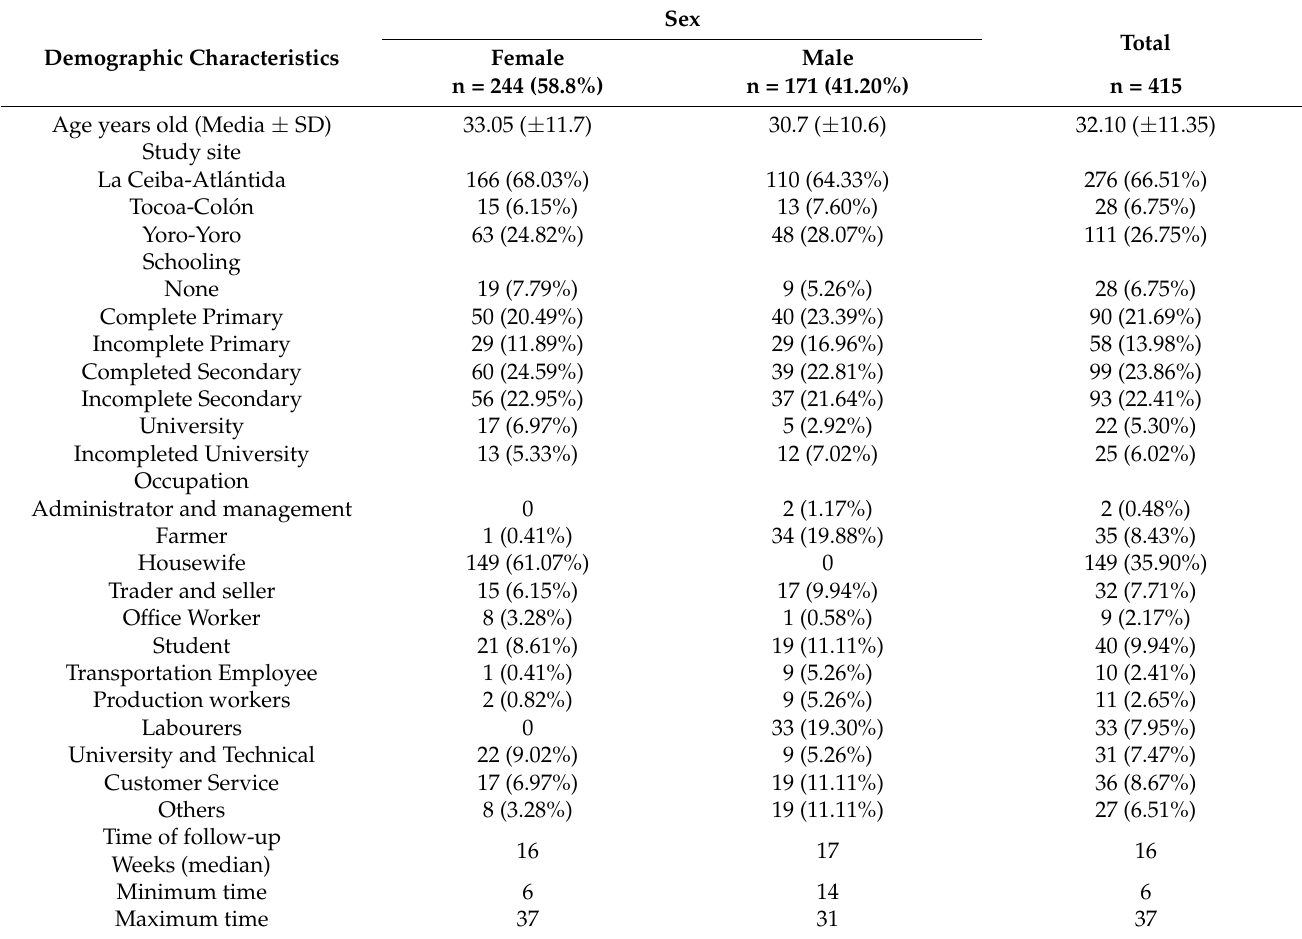
Table 1. Demographic characteristics and time of follow-up in the northern zone of